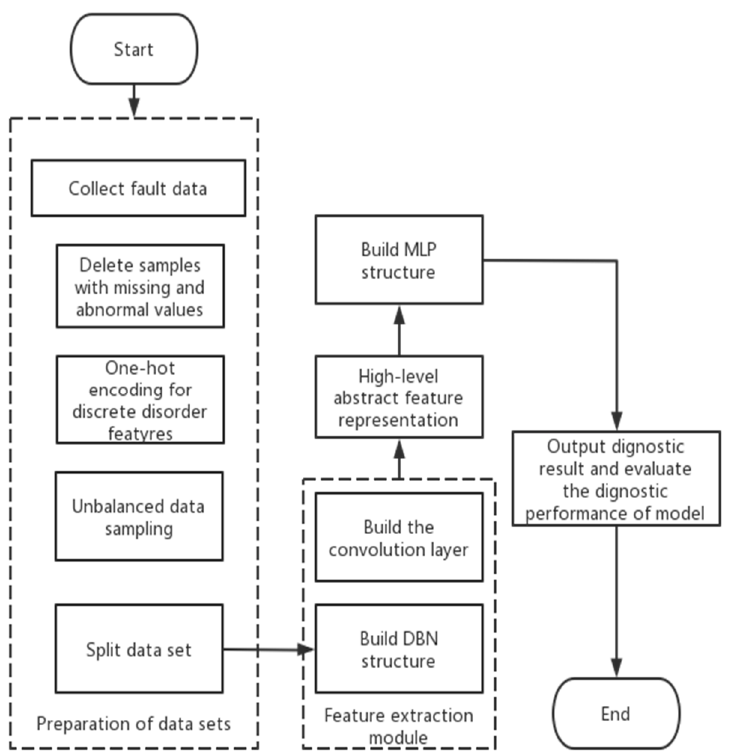
Figure 3. Smart energy meter fault diagnosis process based on the DBN-MLP model.